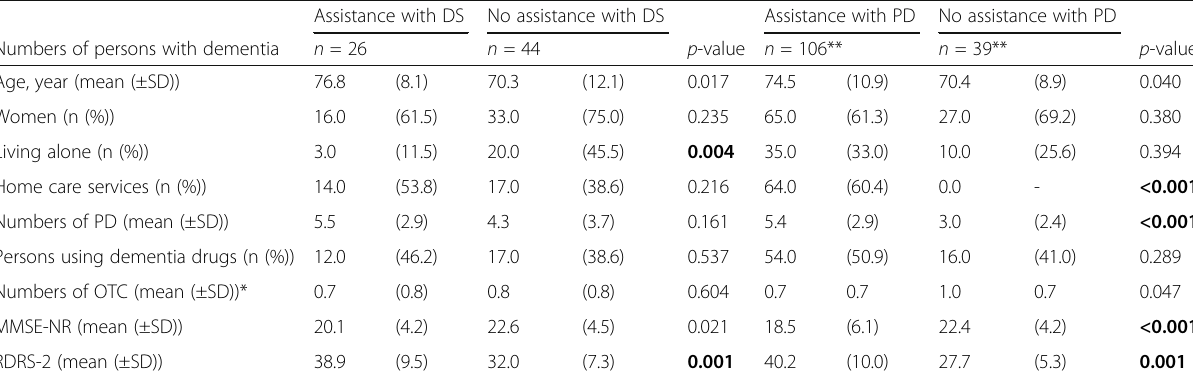
Table 2 Characteristics of adults with dementia receiving assistance with dietary supplements or prescription drugs Assistance with DS No assistance with